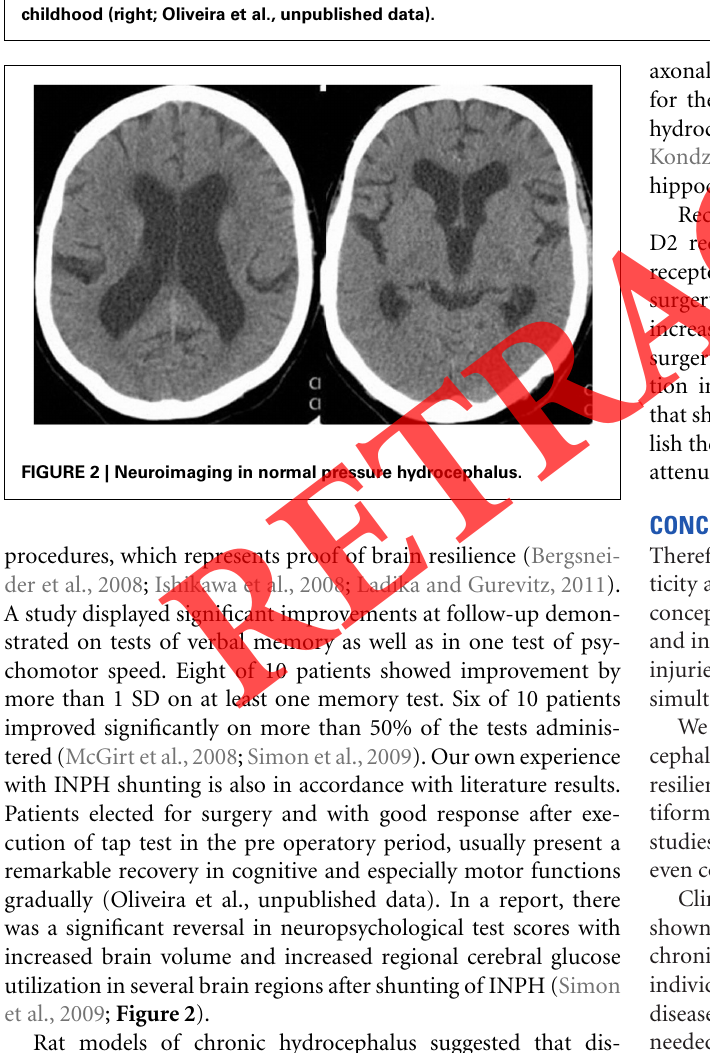
FIGURE 1 |The contrast among a normal brain in a normal adult (left), the brain of a normal man with impressive hydrocephalus (Oliveira et al., unpublished data; middle), and an equally impressive hydrocephalus in a 54-year-old man with deep cognitive and motor impairment since childhood (right; Oliveira et al., unpublished data).